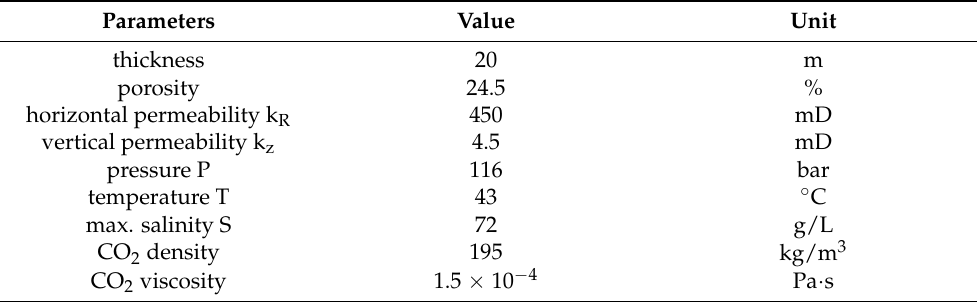
Table 5. Hydrogeological parameters of reservoir rock with medium-grained calcareous sandstone. Parameters Value Unit thickness 20